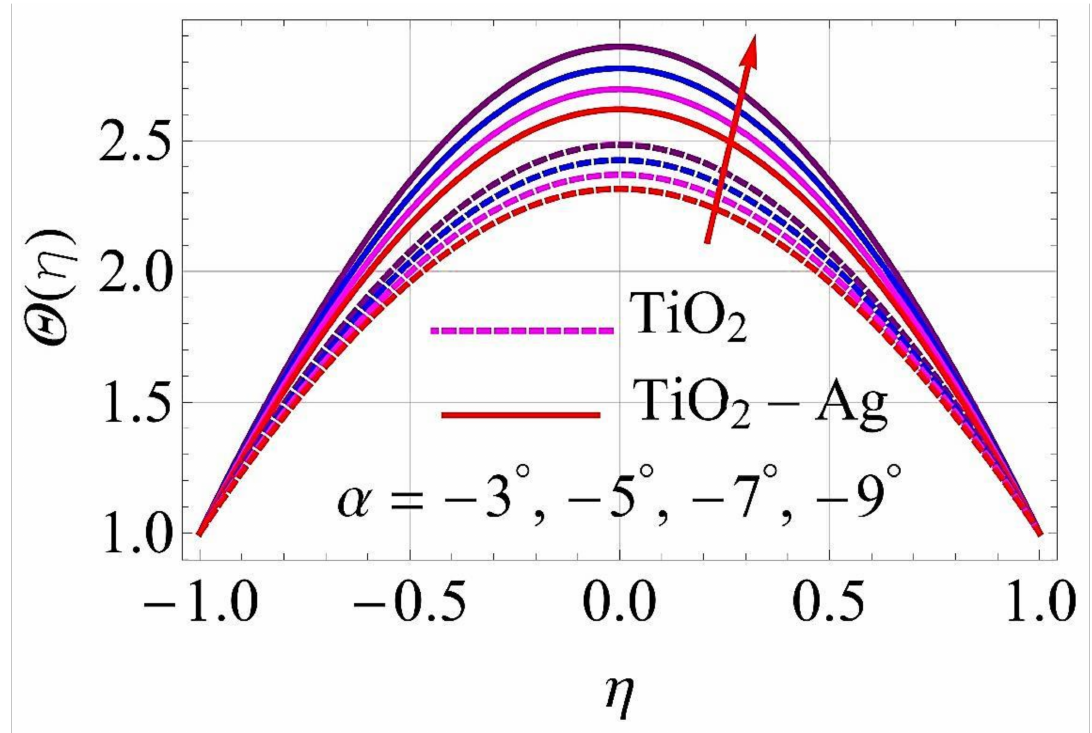
Figure 15. Temperature versus variations in α for converging/stretching circumstances. When Re = 25, φ 1 = φ 2 = 0.01,